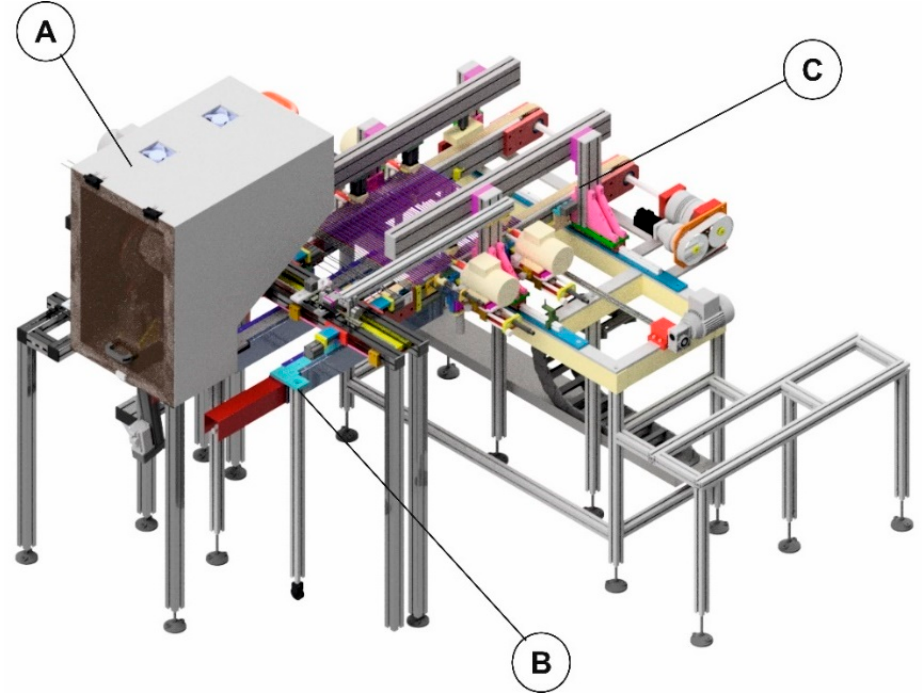
Figure 13. Arrangement of the main systems in the machine.